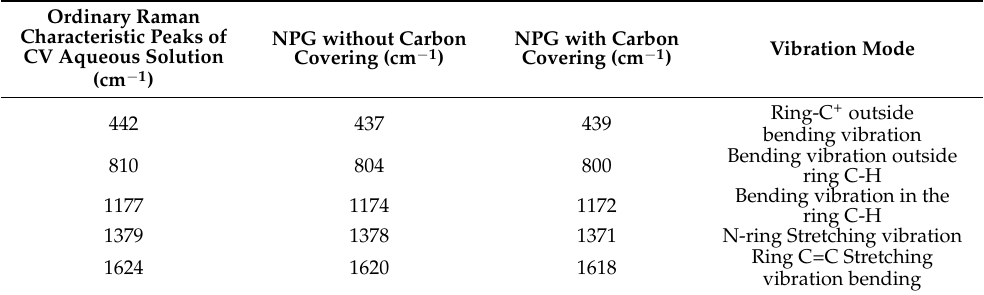
Table 1. Comparison and assignments of Raman characteristic peaks between crystal violet aqueous solution and SERS spectrum.